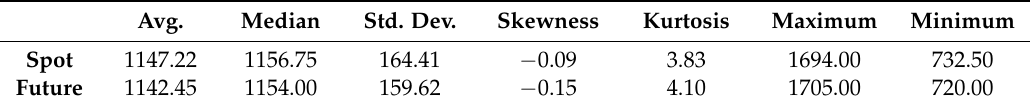
Table 1. Descriptive statistics of ethanol prices—units in Brazilian Reals/m 3